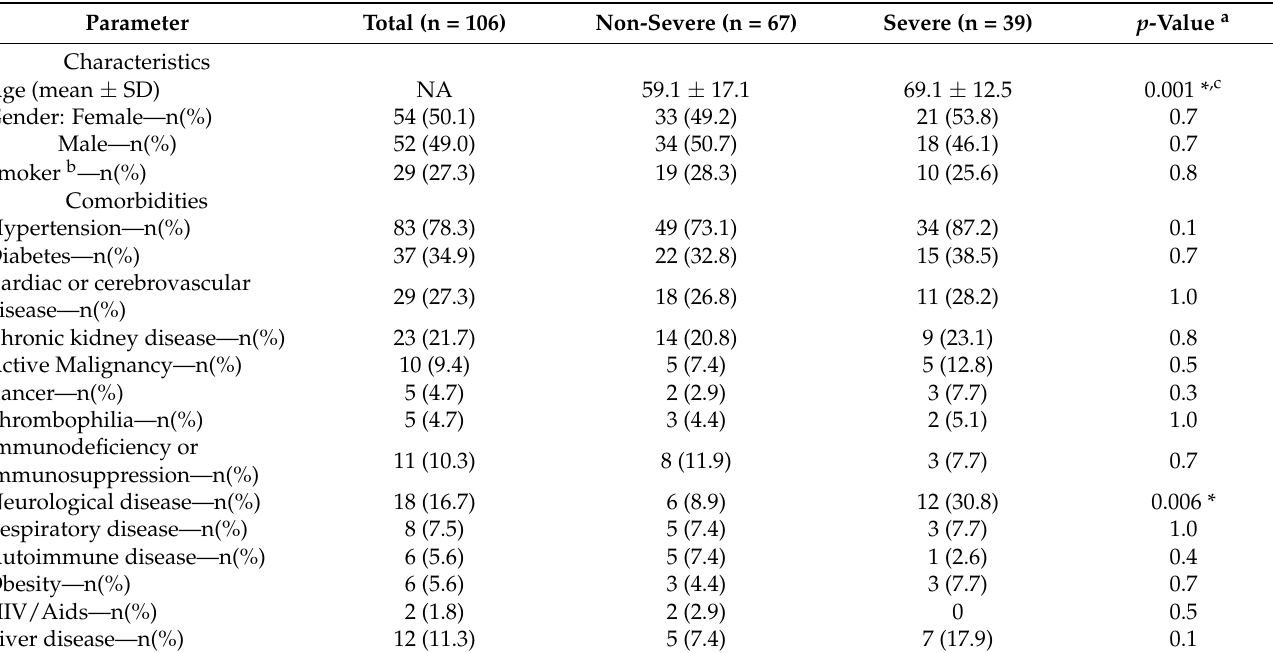
Table 1. Demographic and baseline clinical features of the study patients according to disease